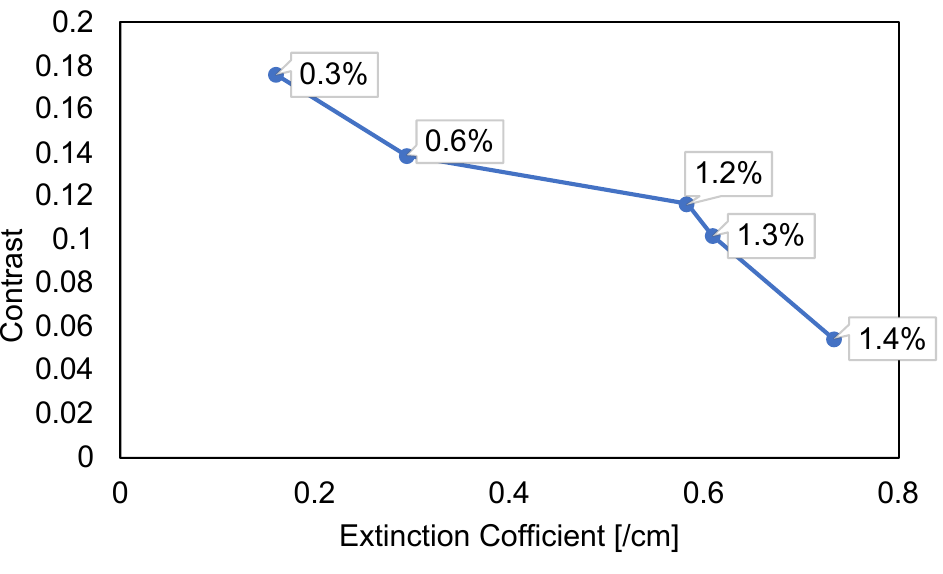
Figure 8. The relationship between the extinction coefficient and the target-surrounding parts’ contrast in 2400 measurements by the DPGI